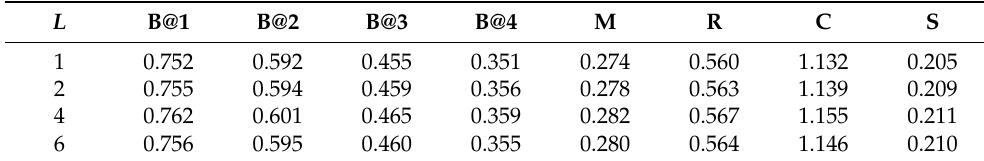
Table 2. The performance of DAT-PoS-Transformer with different numbers of encoding and decoding layers on MSCOCO.